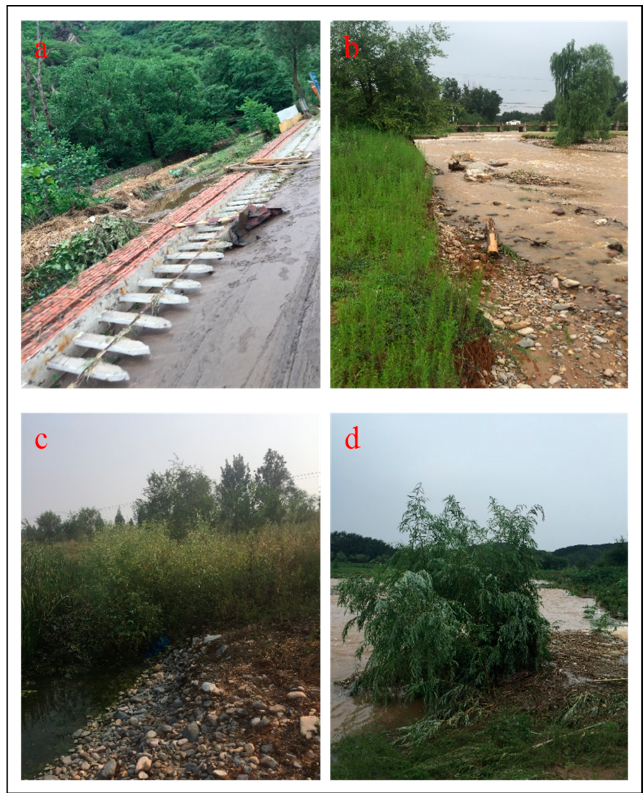
Figure 1. The protection measures damaged by the flood. ( a ) Destroyed retaining wall; ( b ) collapsed riverbank; ( c ) the living brush mattress measure before the flood; ( d ) the living brush mattress measure during the